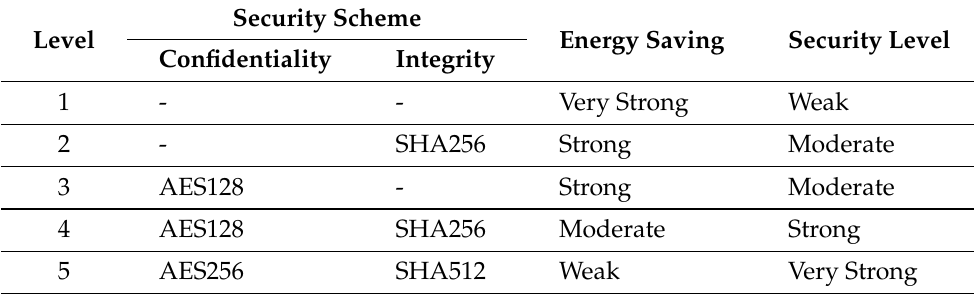
Table 1. Security profiles considered for the proposed